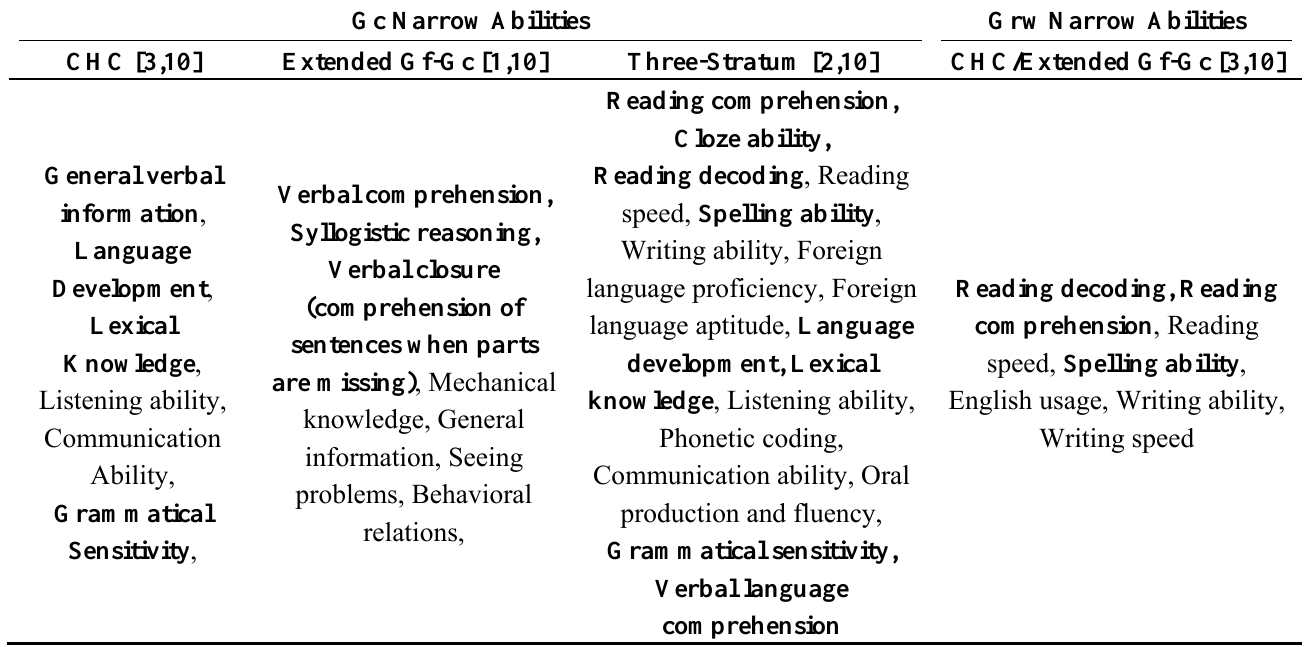
Table 1. Gc (crystallized intelligence) and Grw (reading/writing) narrow abilities according to the three major theories of intelligence and the related C-Test constructs